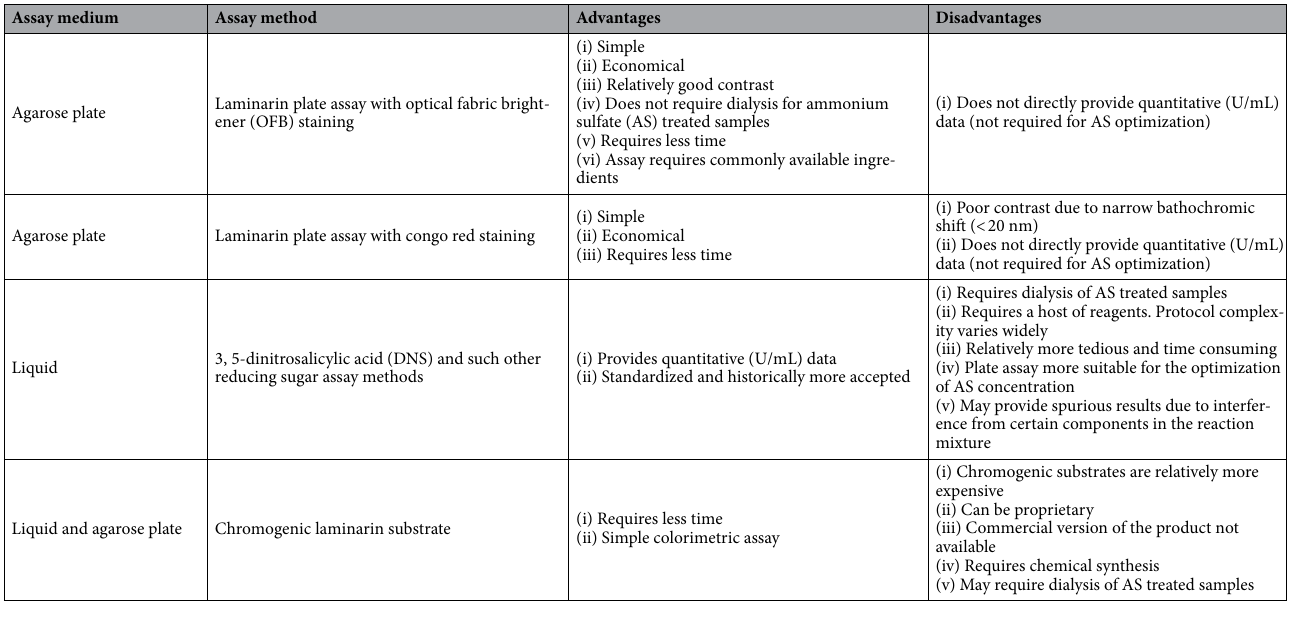
Table 1. Comparison of assay methods for laminarinase